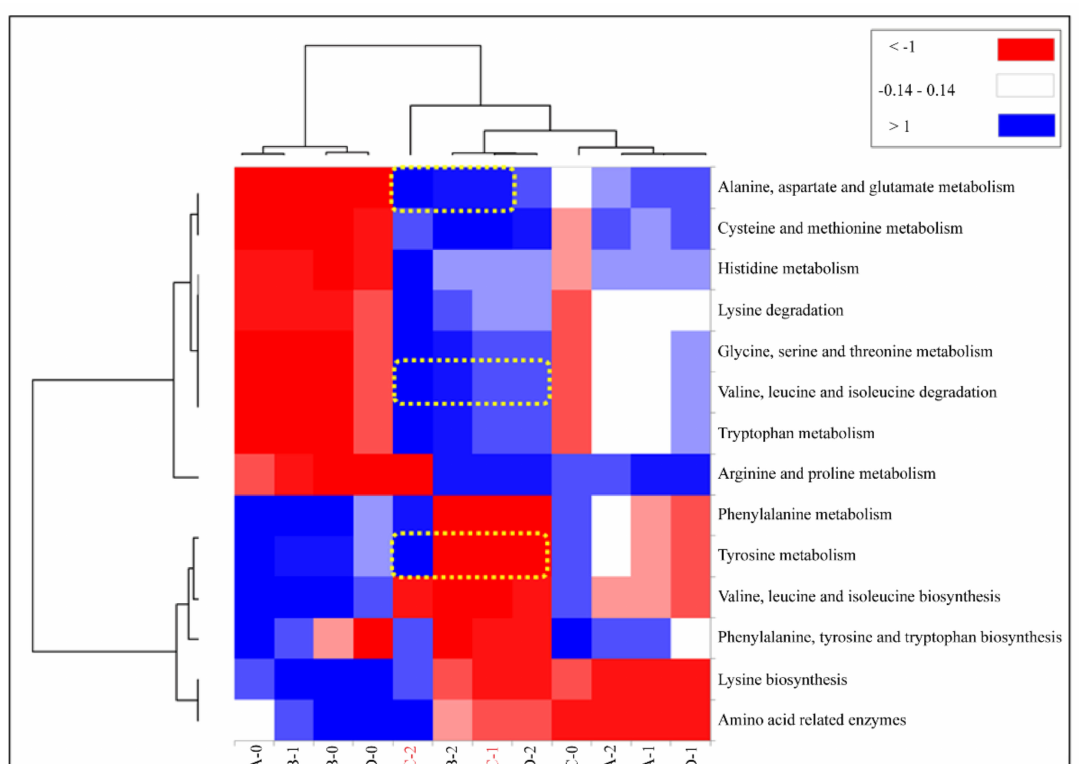
Figure 5. PICRUSt analysis of the operational taxonomic unit data of the metagenome reveals metabolic changes in fermented Meju using different starters. The experimental groups were inocu- lated as follows: A, control without starter; B, Aspergillus oryzae single inoculation group; C, Bacillus velezensis and A. oryzae individual inoculation group; and D, B. velezensis and A. oryzae co-inoculation group, during fermentation for 0–2